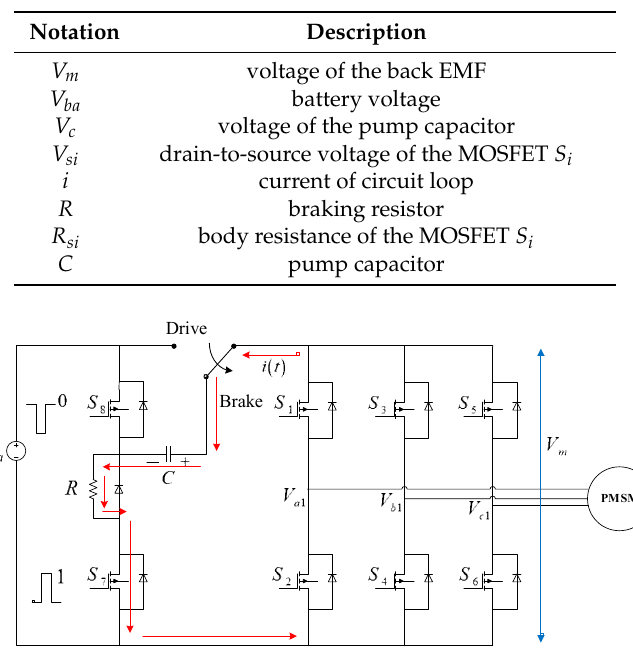
Figure 4. Capacitor charging loop.